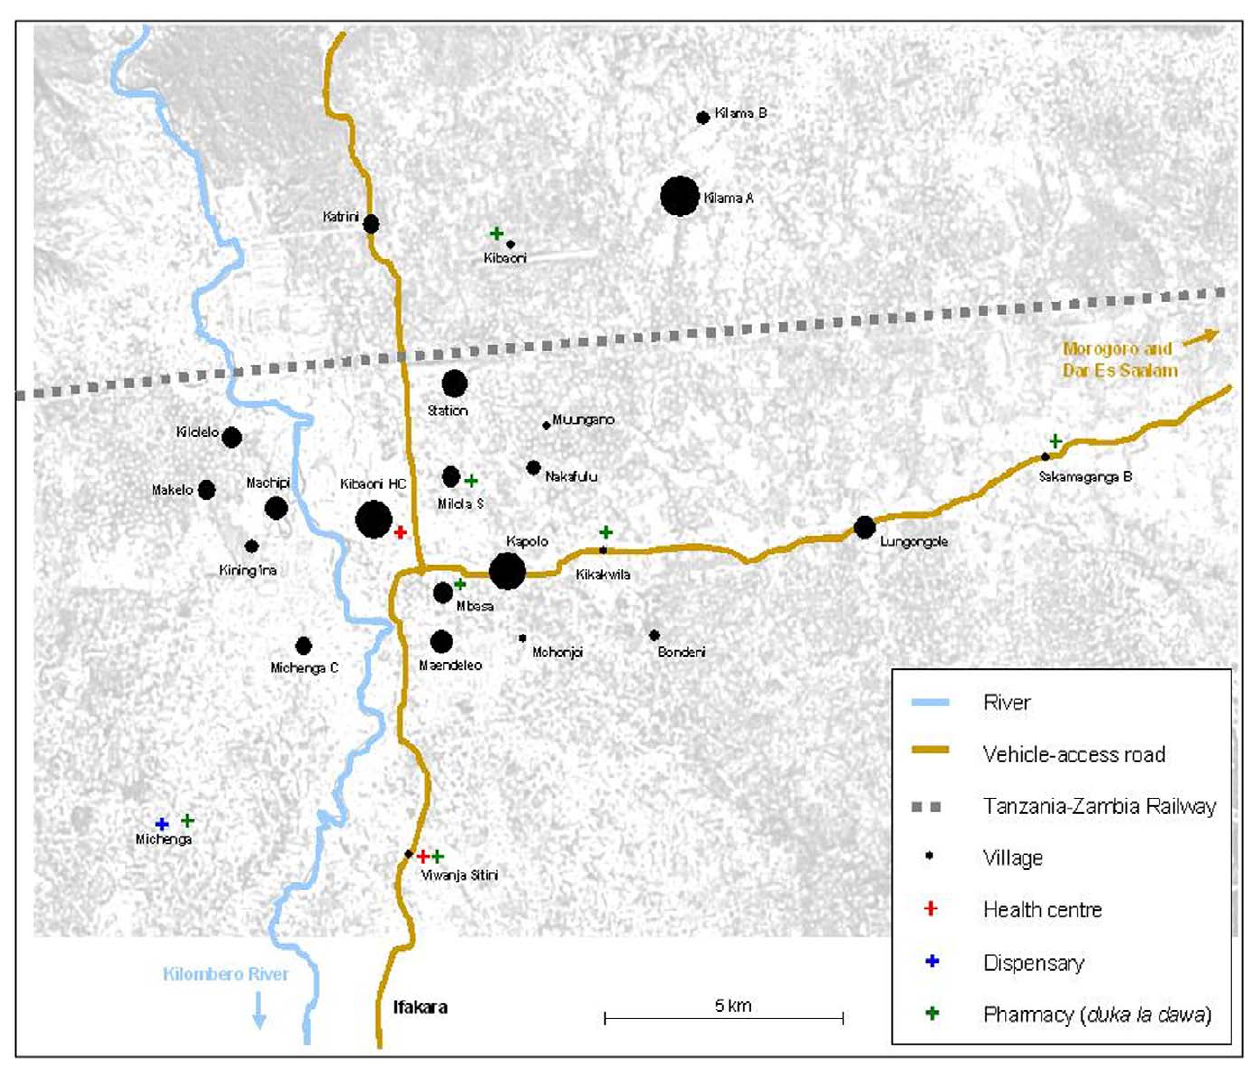
Figure 1. Villages of residence of the patients included in the study.